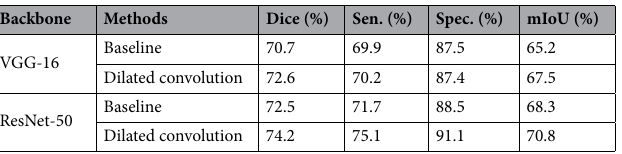
the improvement is marginal (the mIoU score increased from 68.3 to 70.8%). When dilated convolution is used in two blocks, the segmentation performance of the network is obviously improved and achieves the best result size. After that, the network performance begins to decline and when dilated convolution is used in the entire encoder, the performance becomes the worst.